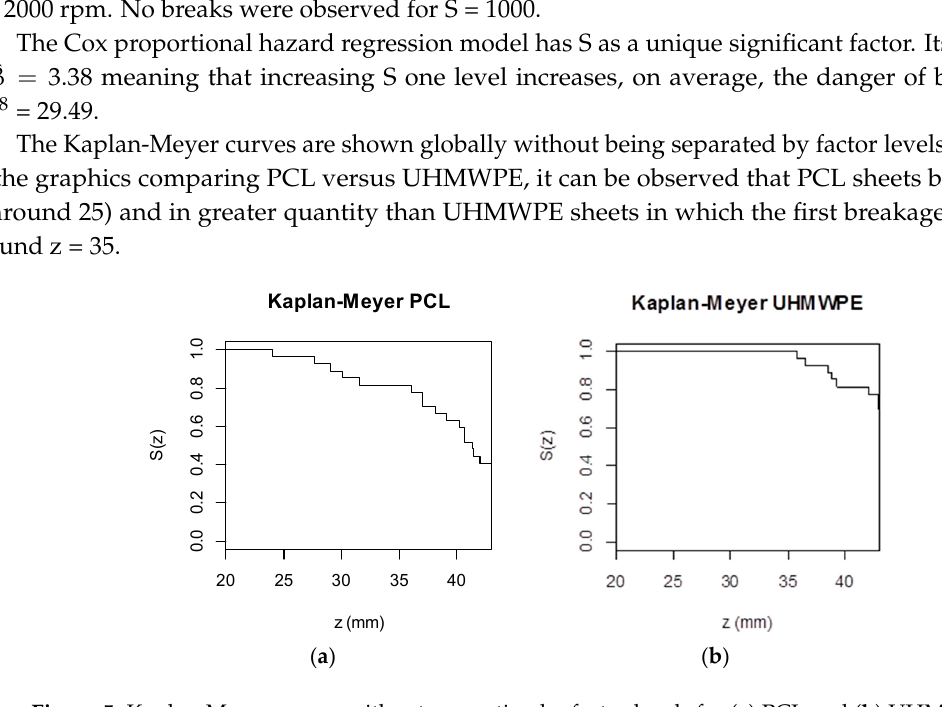
Table 5. Summary of the coefficients of the selected models (bold indicates significance ( α = 0.05)).